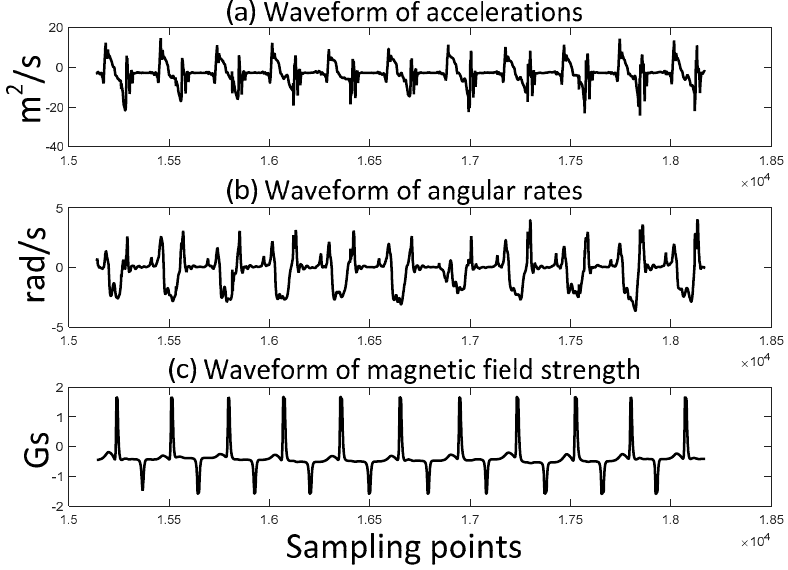
Figure 7. Waveforms of accelerations, angular rates and magnetic field strength during the same time period of walking gait pattern.